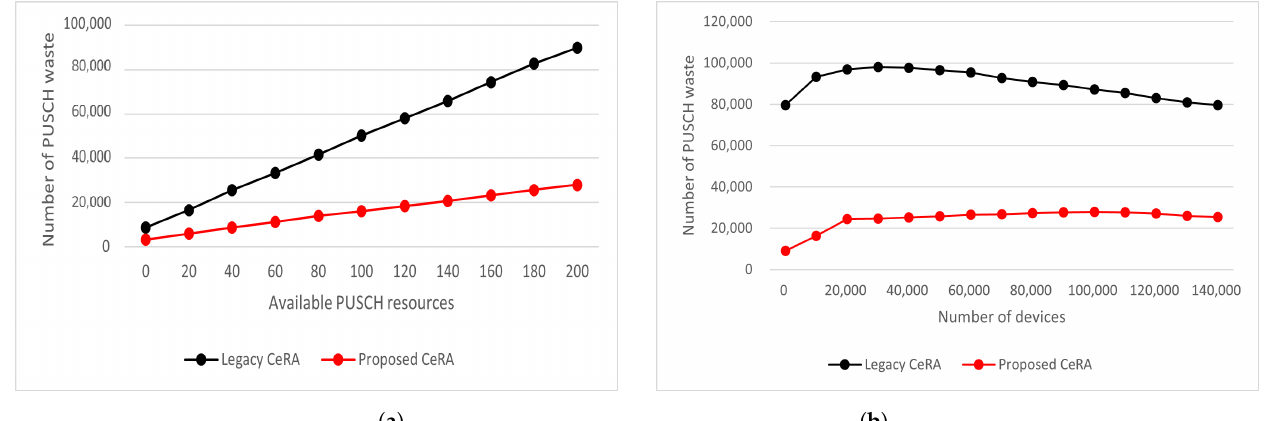
Figure 11. ( a ) PUSCH wastage for different PUSCH resources and ( b ) PUSCH wastage for different numbers of